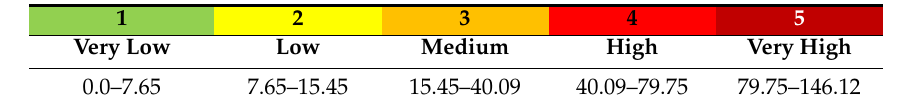
Table 1. Classes of wave energy flux (kw / m), the colors are related to the intensity of possible erosion e ff